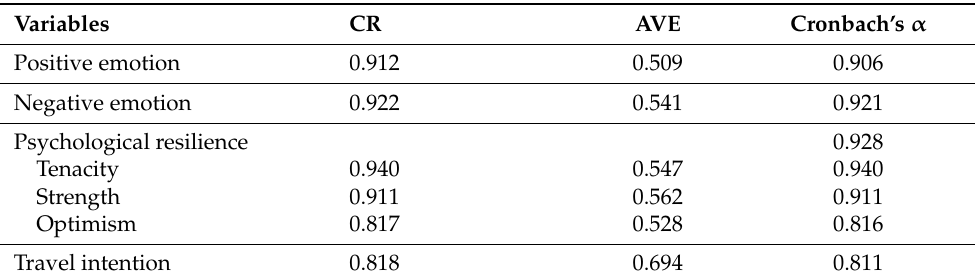
Table 2. Reliability and validity analysis.